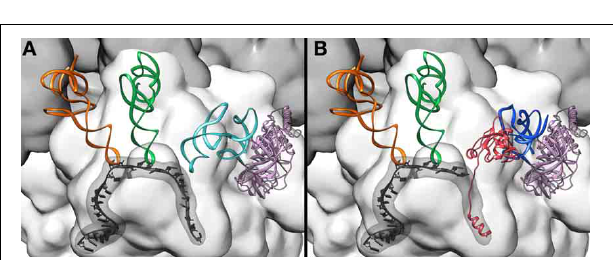
tmRNA binding site interacting with the TLD (indicated with a dotted line) is surrounded by a strong electropositive field. (C) Molecular hydrophobicity potential projected on the solvent-accessible surface of SmpB. The potential was computed with the Platinum server using Ghose force field parameters (Pyrkovetal.,2009).Thehydrophobicityscaleisgreen-white-yellow,withyellow representingthemosthydrophilicregionsandgreenthemosthydrophobic.The primary tmRNA binding site interacting with the TLD (indicated with a dotted line)isformedbyadeephydrophobicpatch. (D–F) Sideviewsoftheinformation presented in (A–C) . Note that in (E,F) , a dotted line indicates the secondary tmRNA binding site that interacts with the nucleotides upstream from the resume codon after translocation of tmRNA-SmpB into the ribosomal P-site.